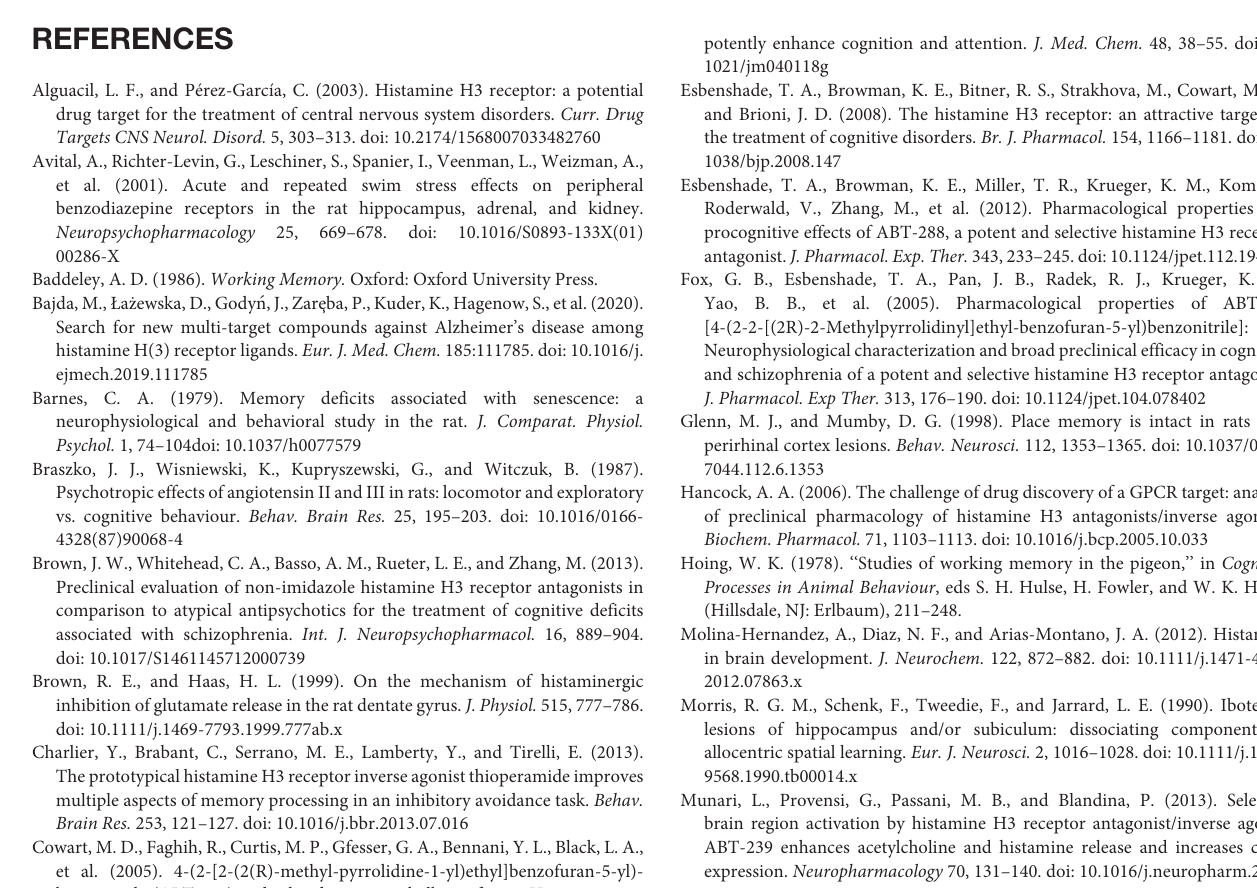
SUPPLEMENTARY FIGURE 1 | Effects of chronic stress, long term ABT-239 administration on the locomotor activity of rats in the Open field. Each column represents the mean ± SEM of the number of crossings, rearings and bar approaches obtained from n rats indicated at the bottom of the figure. SUPPLEMENTARY FIGURE 2 | Effects of chronic stress and long-term ABT-239 pretreatment on the time spent by rats in, or the number of entries to the open arms of elevated plus-maze. Columns represent means ± SEM of the values obtained from n rats indicated at the bottom of the figure. SUPPLEMENTARY FIGURE 3 | Effects of chronic stress and long-term ABT-239 pre-treatment on locomotor performance in reaching visible platform in Morris water maze task. Each column represents the mean ± SEM of first trial obtained from n rats indicated at the bottom of the figure. SUPPLEMENTARY FIGURE 4 | Effects of stress and long-term ABT-239 pre-treatment on working memory expressed in mean savings ratios tested in water maze. Columns represents mean savings ratios ± SEM from nine trials (three trials per day for three days) obtained from n rats indicated at the bottom of the